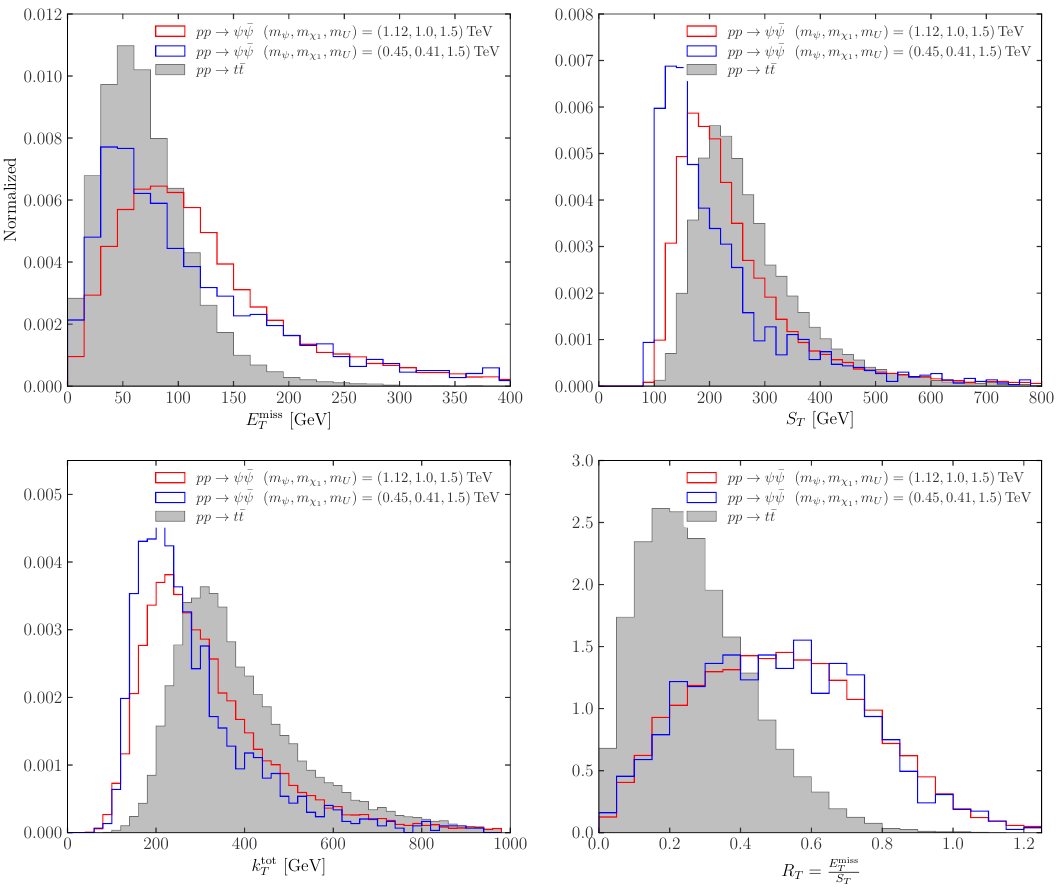
, S , k tot and R event distributions for two benchmark signal pro- Figure 5 . Normalised E miss T T T T cesses (red, blue) and for the t ¯ t background (grey). See main text for details. values ( m ) = (1 . 12 , 1 . 0 , 1 . 5) TeV (red) and ( m ) = (0 . 45 , 0 . 41 , 1 . 5) TeV , m , m , m , m χ 1 χ 1 U U ψ ψ (blue) that satisfy the dark matter relic abundance requirement, and the t ¯ t background (shaded